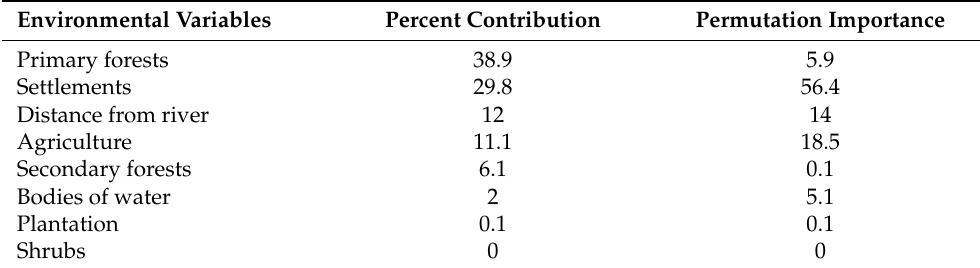
Table 5. Contribution of each environmental variable.